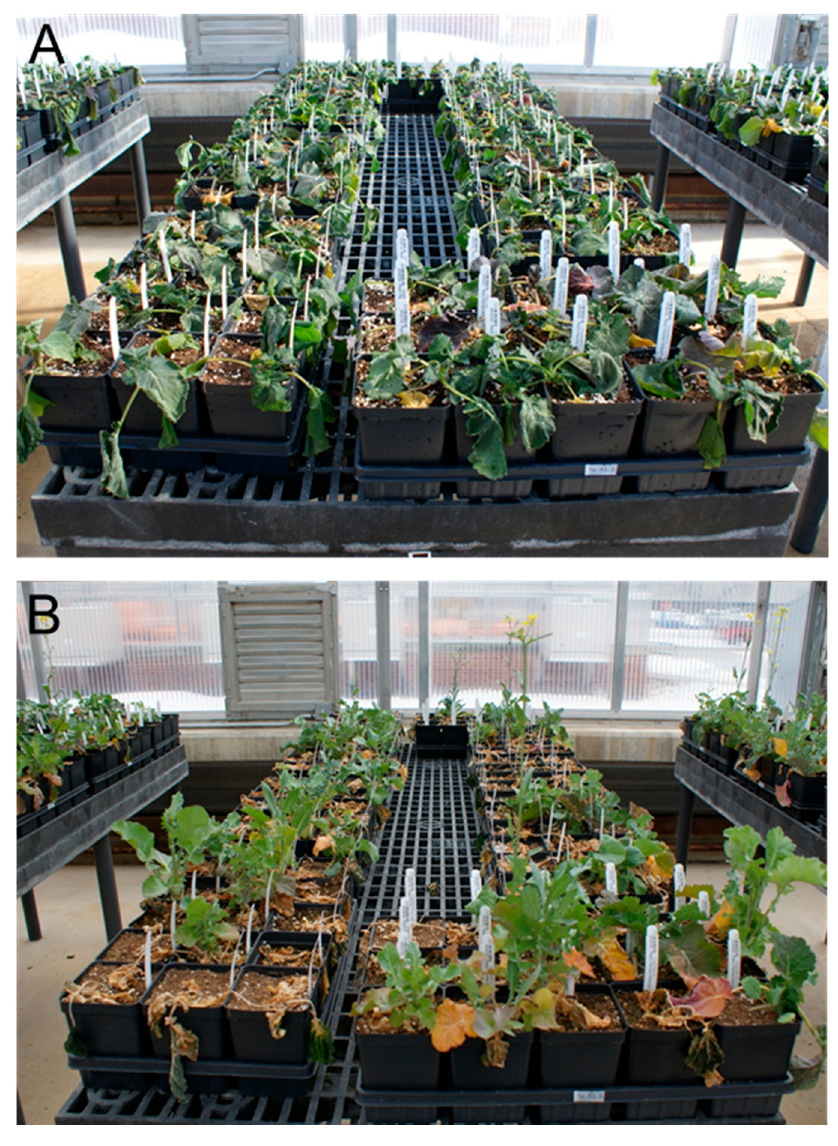
Figure 2. Leaf damage post-freezing. Plants were subjected to − 15 °C for 4 h and transferred to a greenhouse. ( A ) The photo was taken right after the end of the freezing treatment. ( B ) The photo was taken four weeks after the transfer to greenhouse.